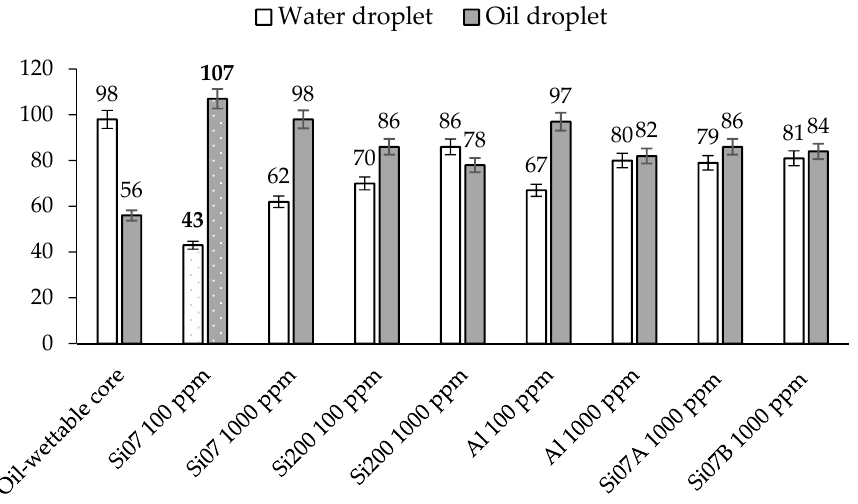
Figure 5. Contact angles to oil and water measured at 25 °C for oil-wettable systems before and after being treated with aqueous dispersions of Si07, Si200 and Al at 100 and 1000 ppm at 77 °C for 24 h.